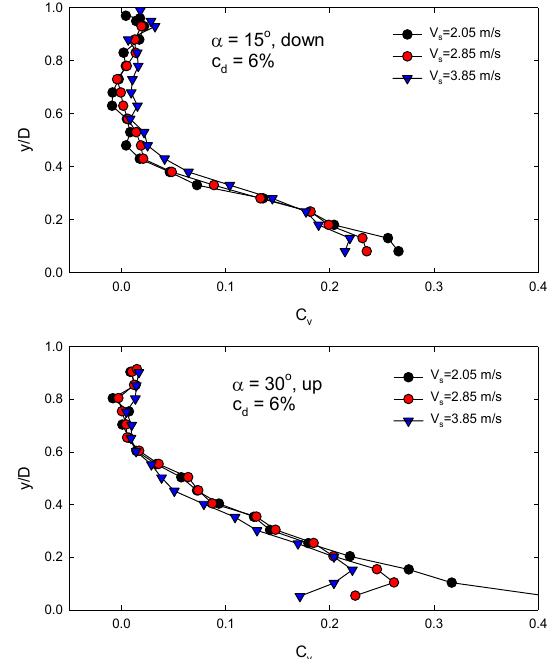
Fig. 7. Effect of the mean mixture velocity V s on local concentration c v .